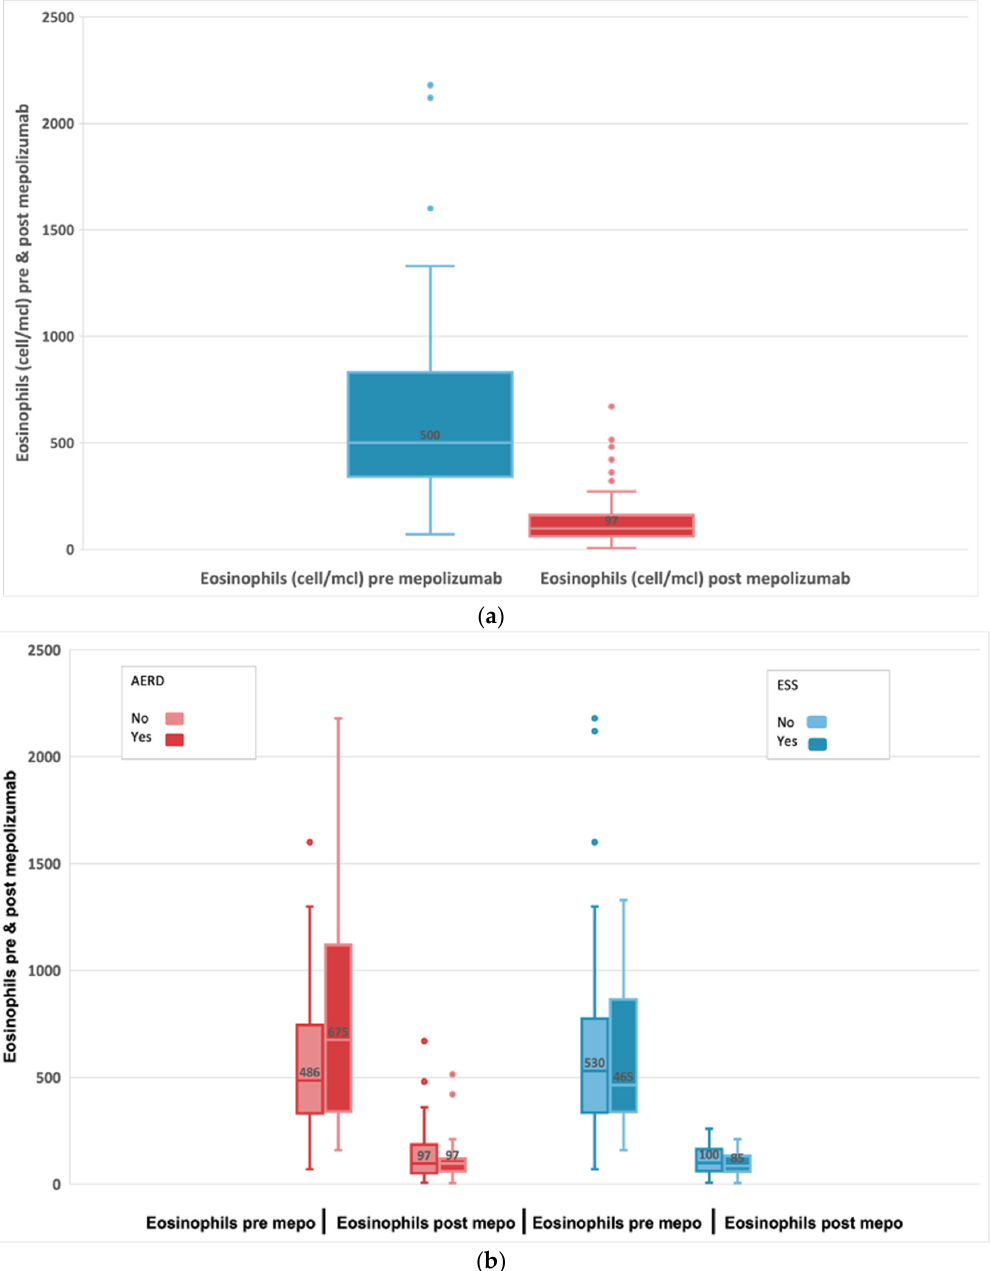
Figure 4. ( a ) Evolution of absolute blood eosinophils in subjects with refractory chronic rhinosinusitis and nasal polyps, pre-treatment and after 24-week treatment with 100 mg of mepolizumab every 4 weeks. ( b ) Evolution of blood eosinophils before and after 24-week treatment with 100 mg of mepolizumab every 4 weeks among patients with AERD compared to non-AERD and subjects with previous surgery compared to non-previous surgery.